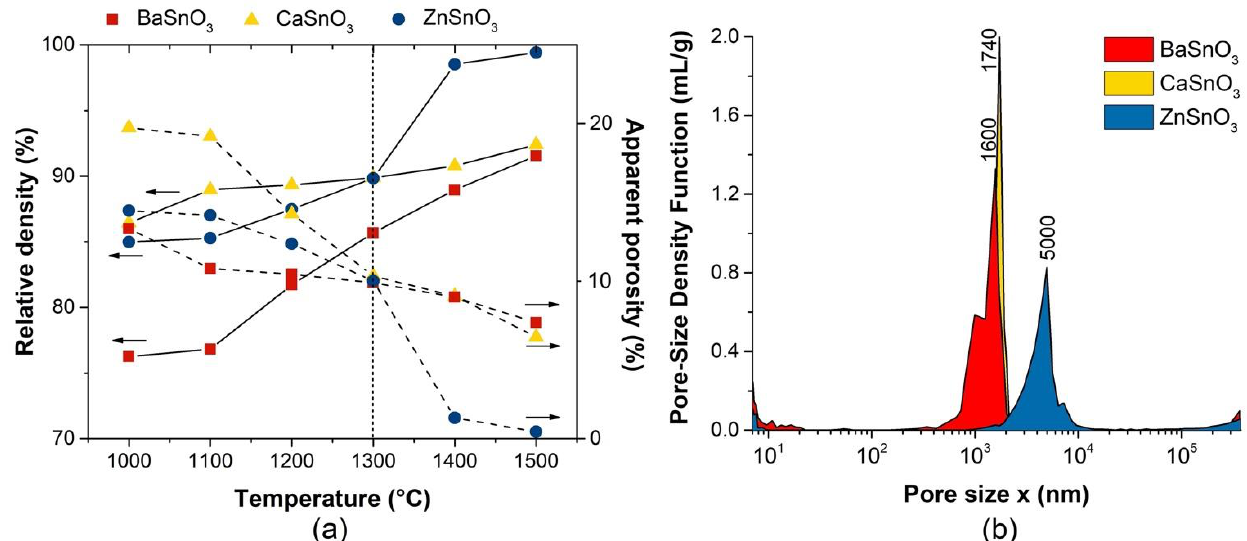
Figure 4. ( a ) Densification and apparent porosity, and ( b ) pore size distribution of the MSnO 3 (M = Ba, Ca, Zn) bodies. The relative densities are related to the theoretical densities of 7.33 g/cm 3 (BaSnO 3 ), 5.53 g/cm 3 (CaSnO 3 ), and 6.79 g/cm 3 (ZnSnO 3 ).